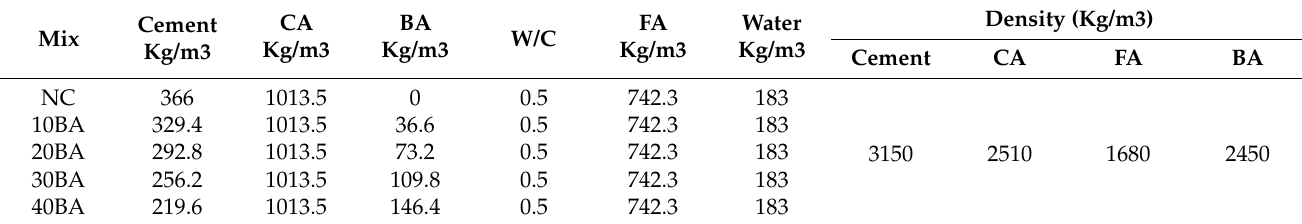
Table 3. Detailed mix design proportions of the control and modified